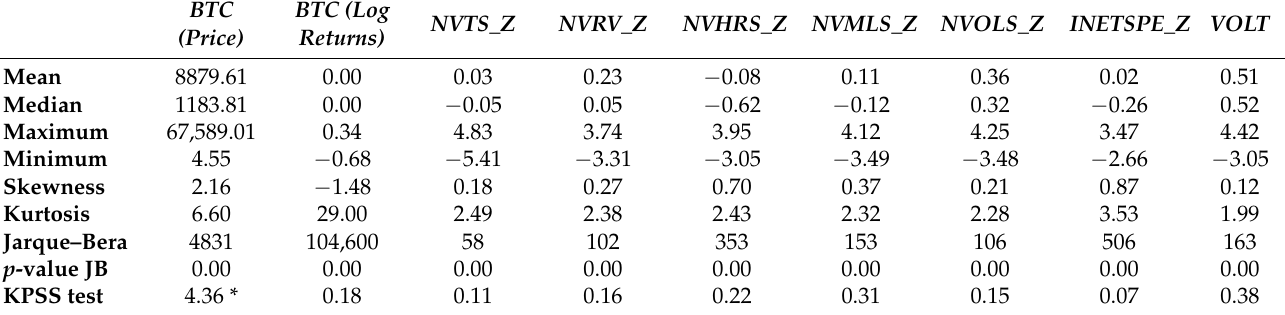
Table 3. Descriptive statistics, Jarque–Bera normality test statistic and p -value, and KPSS unit